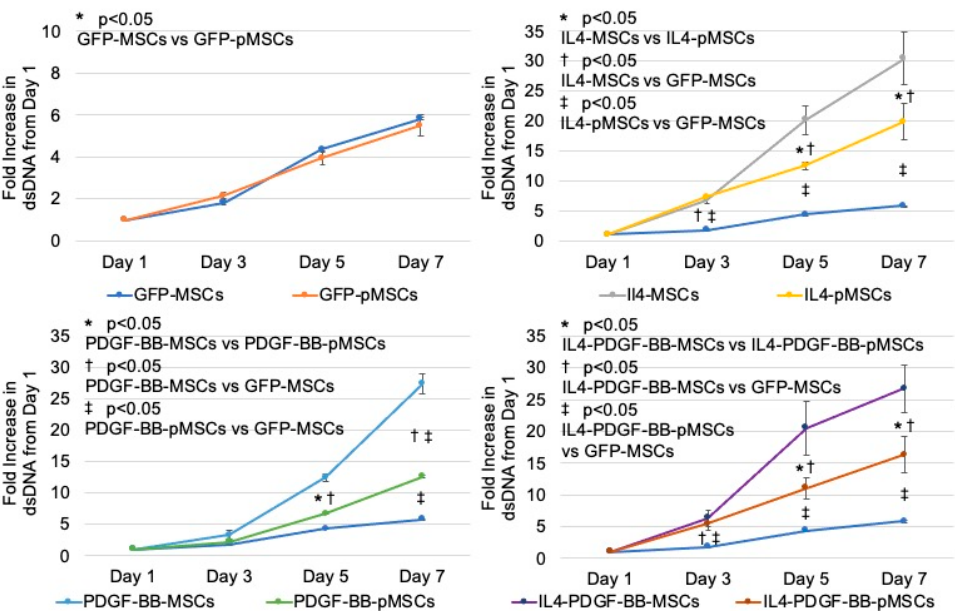
Figure 3. Cell proliferation measured by PicoGreen dsDNA quantitation assay.